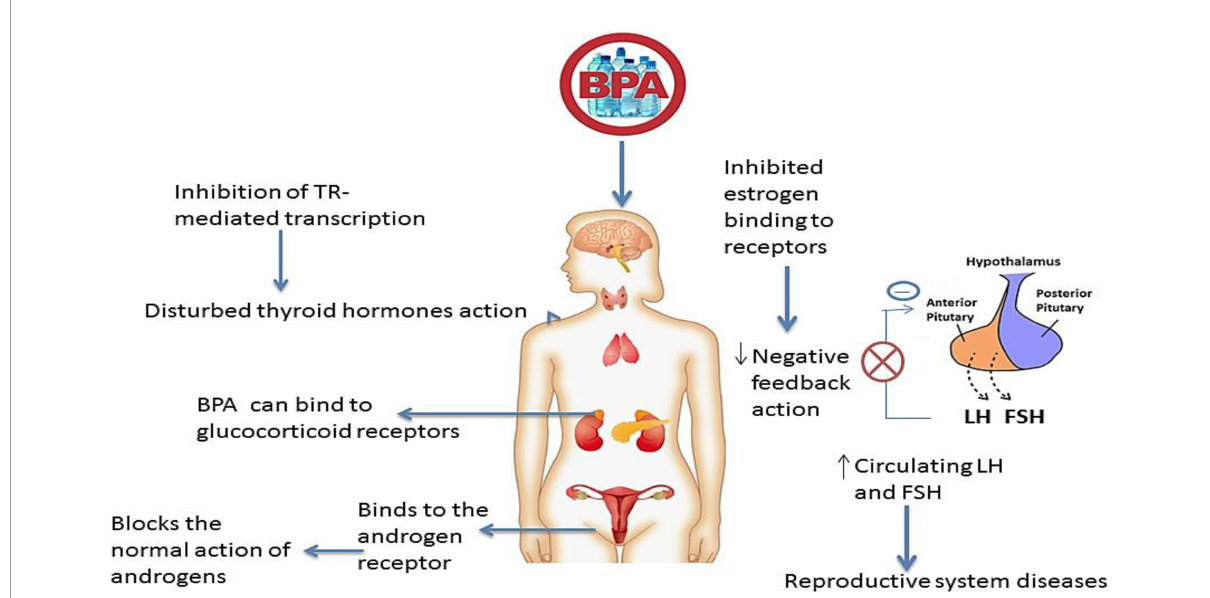
FIGURE2 Bisphenol A as an endocrine disruptor. Estrogens negatively affect the release of follicle-stimulating hormone (FSH) and luteinizing hormones (LH). BPA can inhibit the estrogen binding to its receptors at the pituitary level, resulting in high levels of FSH and LH hormones in circulation. This can lead to reproductive system issues such as polycystic ovarian syndrome. BPA acts as anti-androgen by binding with androgen and glucocorticoid receptors and affecting their action. BPA can disturb the action of the thyroid hormone by inhibiting TR-mediated transcription of T 3 -response